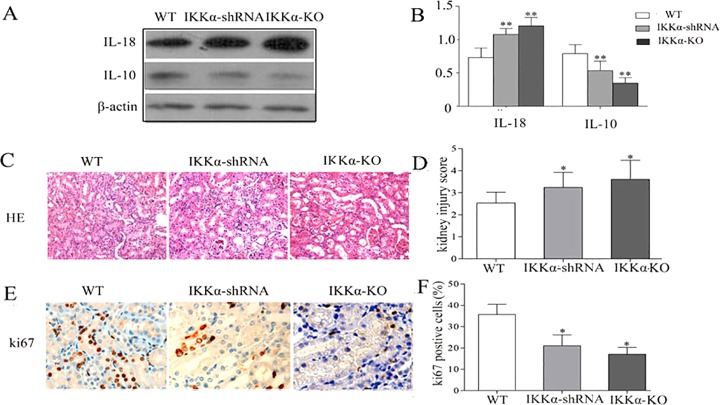
Silencing IKKα impairs inflammation resolution and tubular proliferation of IR kidneys. C57BL/6 wild-type mice underwent IR by unilateral renal pedicle clamping for 45 min followed by reperfusion (WT) or IR conducted 2 weeks after renal parenchyma injection of GV118-GFP-shRNA-IKKα lentiviral vectors (IKKα-shRNA). We also carried out unilateral ischemic injury in IKKα-null mice (IKKα-KO, IKKαfl/fl, Cre+/− mice). The kidneys were harvested on day 3. (A,B) Protein levels of IL10 and IL18 were measured by western blotting. (C) Hematoxylin and Eosin staining of renal cortex. Kidneys from IKKα-shRNA or IKKα-KO mice showed significantly more tubular damage than wild-type kidneys. (D) The histological damage score was determined in a blind manner. (E) The cells stained reddish-brown represent Ki67-positive cells, reflecting the proliferation process; (F) they were quantified in a blind manner. Data are presented as mean±s.d. (n=6 mice). *P<0.05 versus wild type, **P<0.01 versus wild type.